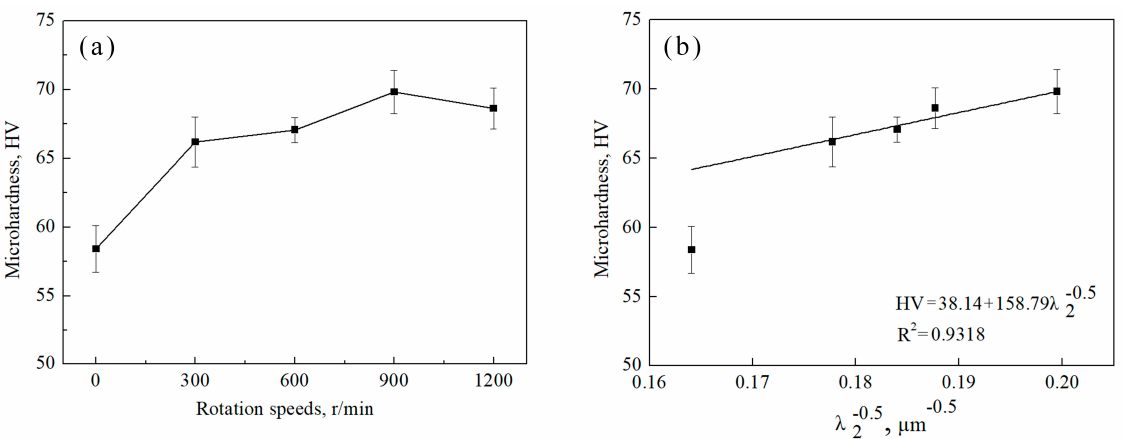
Figure 7. The microhardness of the Ag–1.5Cu–1.0Y alloys under different rotation speeds ( a ) and the linear fitted Hall–Petch relationship between the microhardness and the λ 2 ( b ).